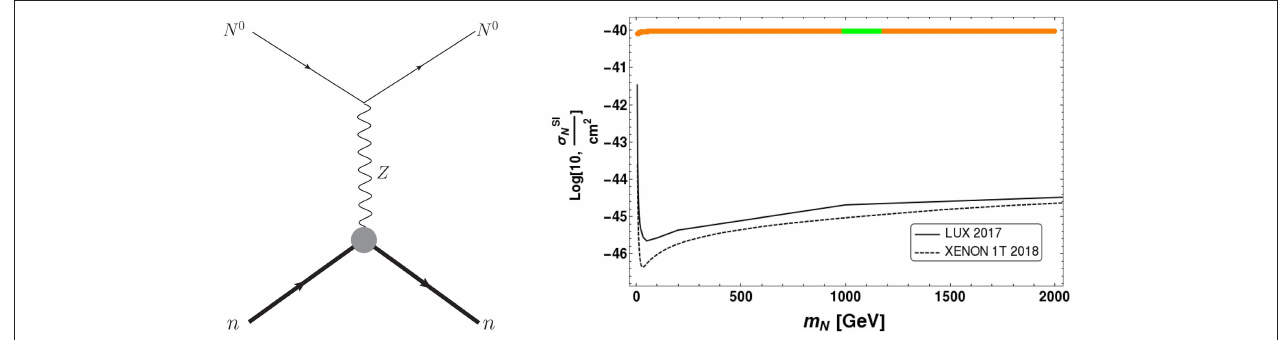
FIGURE 6 | Left : Feynman diagram for direct detection (DD) of DM, N 0 . Right : Spin independent(SI) DM-nucleon cross-section is plotted in m N density allowed DM mass region is indicated here by green patch.